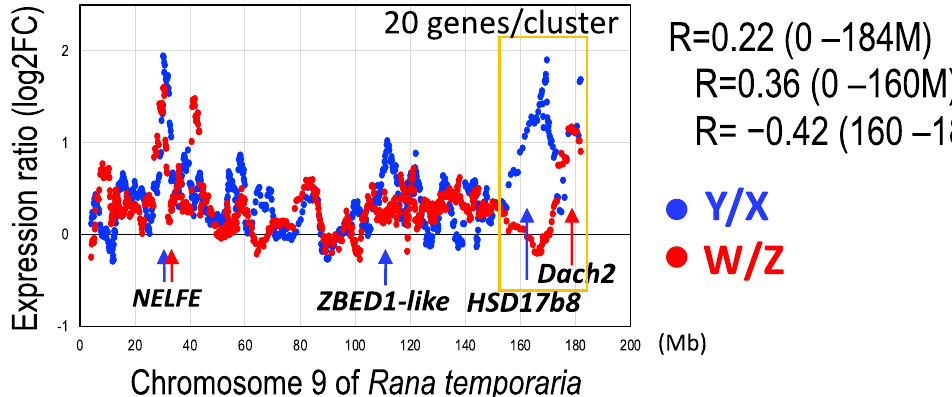
Figure 7. Distribution of the allelic expression ratios of the sex chromosome-linked genes along the chromosomal axis. Blue circles indicate the expression ratios of Y-genes to X-genes, and red circles indicate those of W-genes to Z-genes. The genomic region from 160 to 184 mega bases is boxed in yellow. Arrows indicate the chromosomal positions of the sex determining gene candidates with high expression ratios of Y/X (blue) and/or W/Z (red). The abbreviations are the same as in Figure 4.